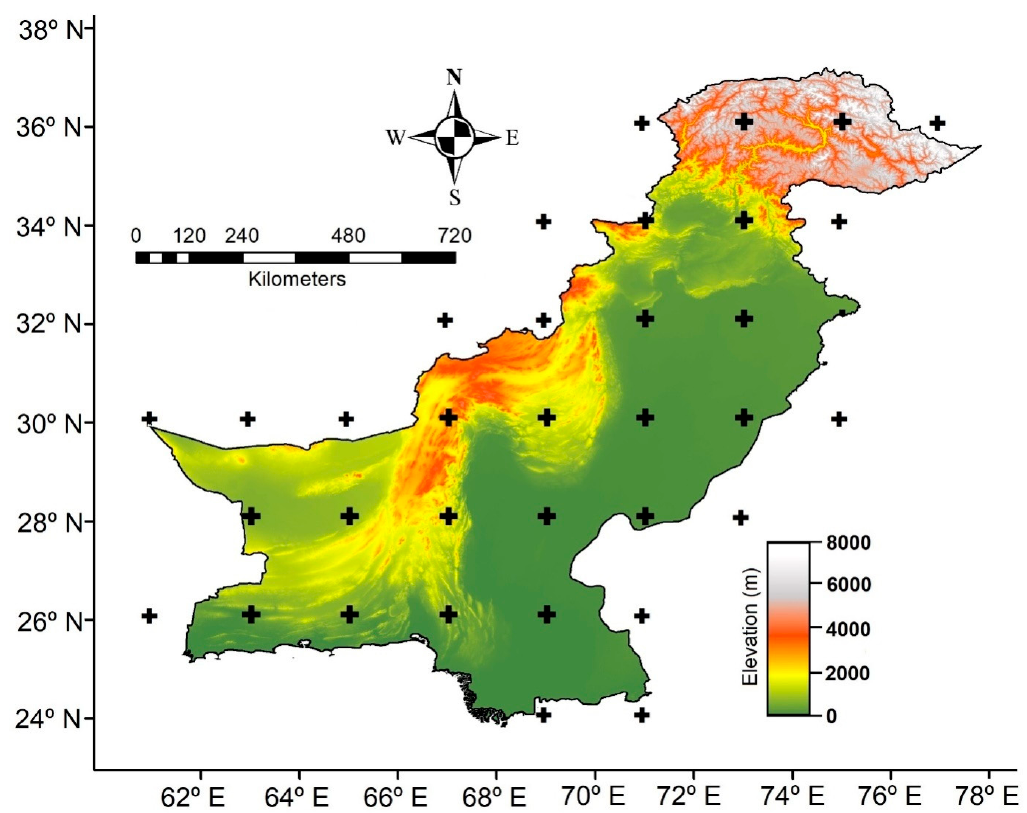
Figure 1. Topographical map of the study area with the distributed points at 2° × 2°.